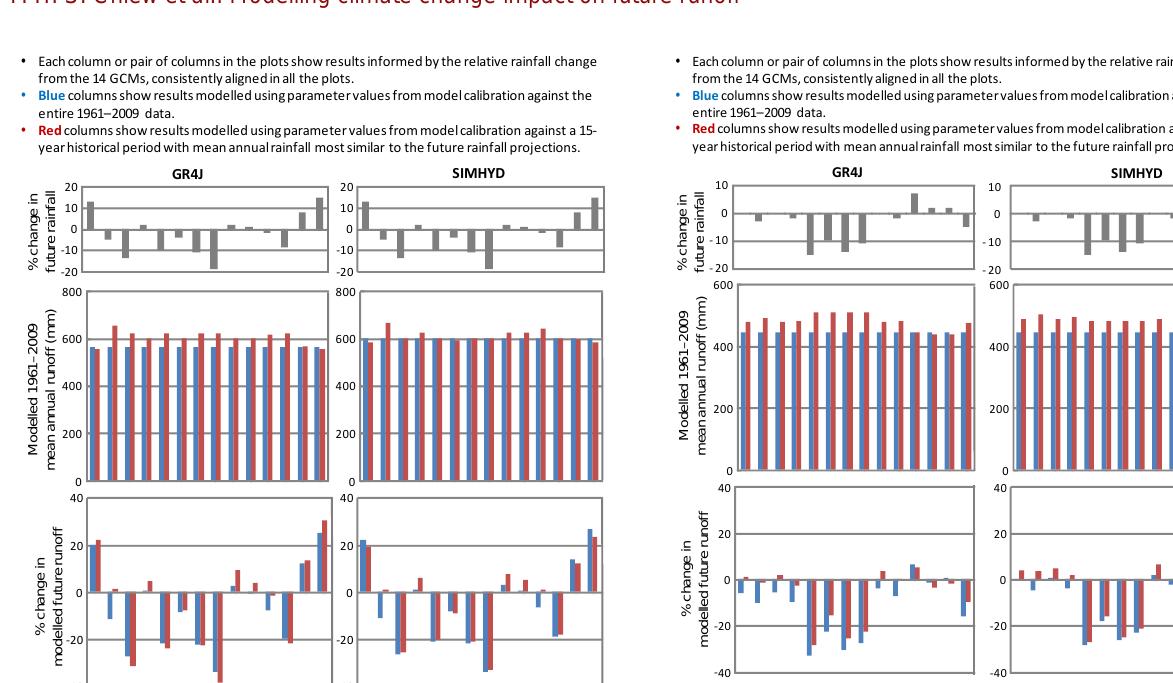
Figure 2. Modelling results for Catchment 110003. Figure 2 Modelling results for Catchment 110003